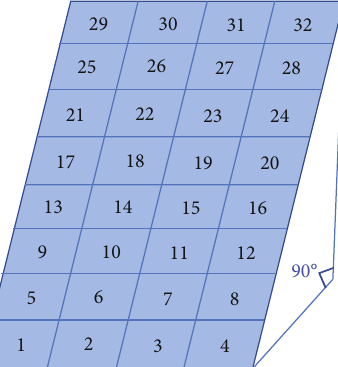
Figure 2: Discretization of the three-dimensional fracture along both the horizontal axis and the inclined